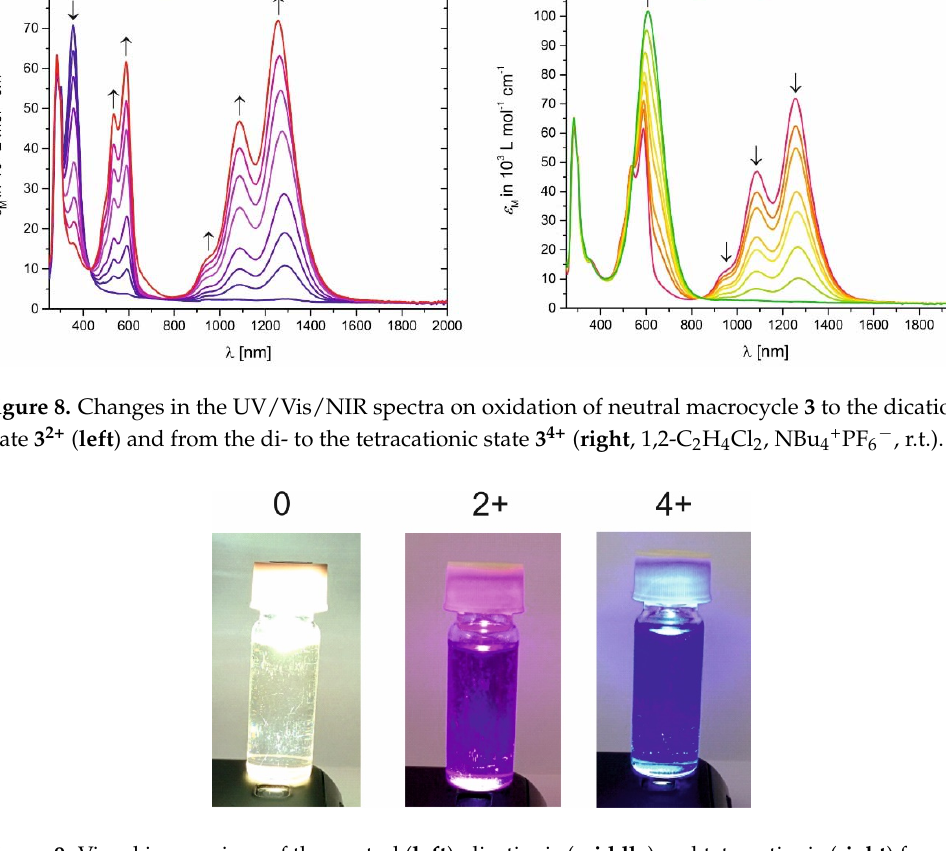
Figure 9. Visual impressions of the neutral ( left ), dicationic ( middle ) and tetracationic ( right ) forms of macrocycle 1 at concentration levels of 200 μ M in CH 2 Cl 2 solution.